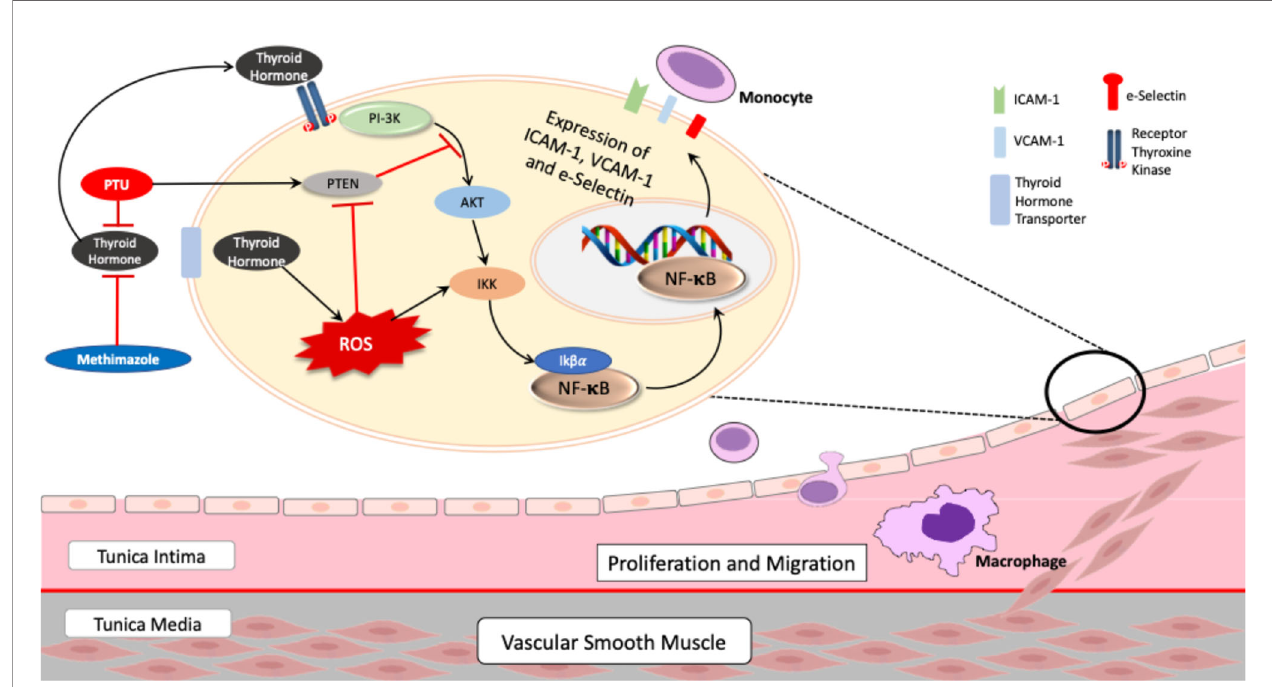
FIGURE 4 | Proposed mechanism of PTU and methimazole in pathophysiology of atherosclerosis in Graves ’ disease. AKT, protein kinase B; NF- k B, nuclear factor- kappa B; IKK, IK b kinase; PI-3K, phosphoinositide 3-kinase; PTEN, phosphatase and tensin homolog; PTU, propylthiouracil; ROS, reactive oxygen species; intercellular adhesion molecule-1; VCAM-1, vascular cell adhesion molecule-1. Thyroid hormone induces activation of the PI-3K/AKT/IKK/NF- k B pathway, which in turn increase expression of adhesion molecules — ICAM-1, VCAM-1, and E-selectin. In addition, thyroid hormone also increases ROS, amplifying NF- k B activation through IKK. However, treatment with PTU can block the PI-3K/AKT/IKK/NF- k B pathway by inducing the expression of PTEN, a tumor-suppressor gene that can block the PI-3K/AKT pathway, resulting in less expression of adhesion